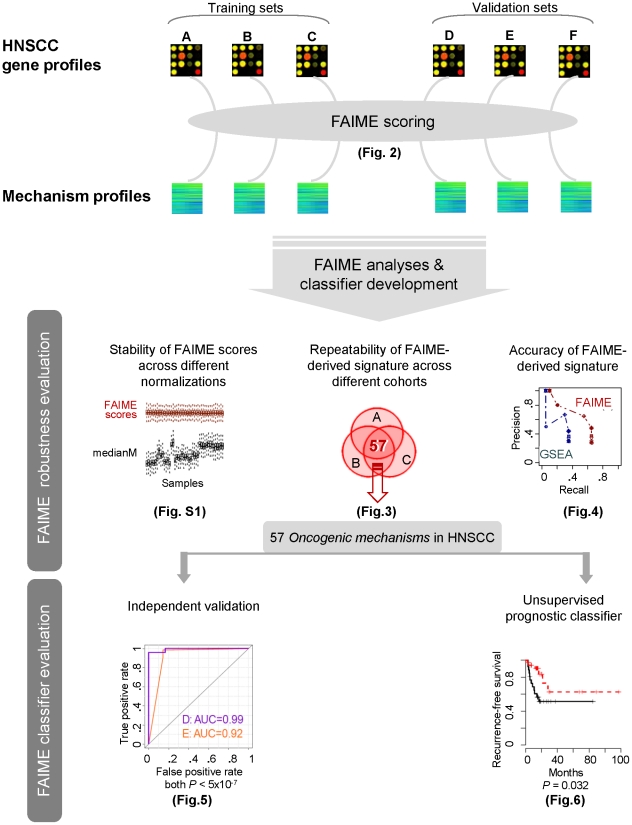
Outline for conducting HNSCC recurrent-free survival prediction using FAIME-derived mechanism profiles of individual samples.FAIME-derived individual mechanism profiles are generated from six independent HNSCC gene expression profiles (Figure 2 in the main manuscript). Then the FAIME Scores are evaluated theoretically for robustness (Figures 3–4, S1) and clinically for new patient diagnosis and survival prediction (Figures 5, S5, 6, S6).